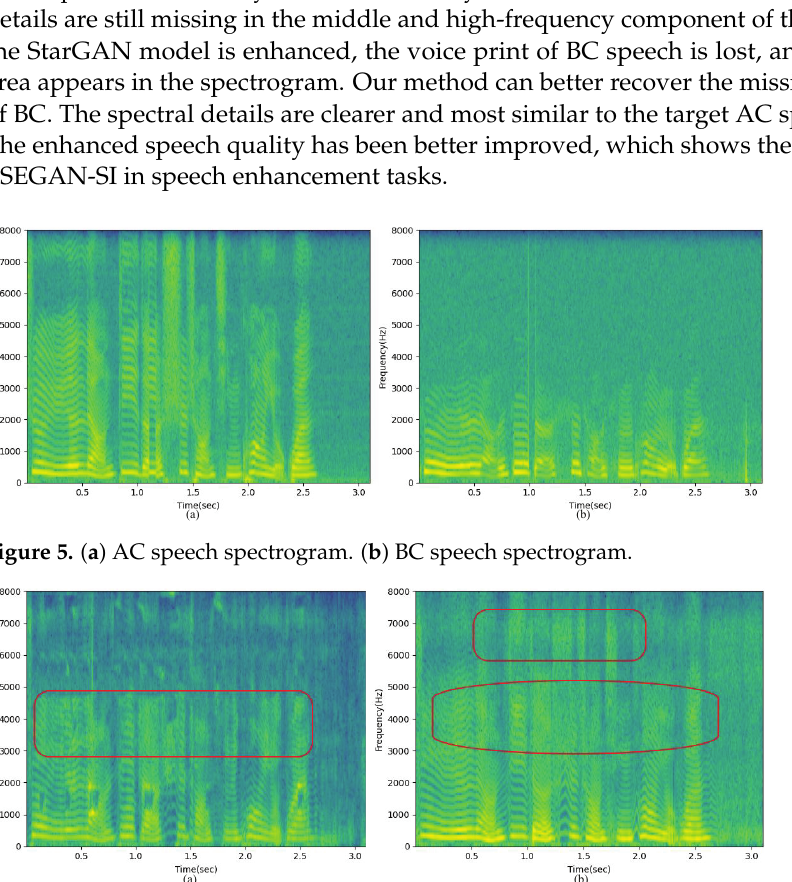
Figure 6. ( a ) Enhanced BC speech spectrogram by GMM. ( b ) Enhanced BC speech spectrogram by